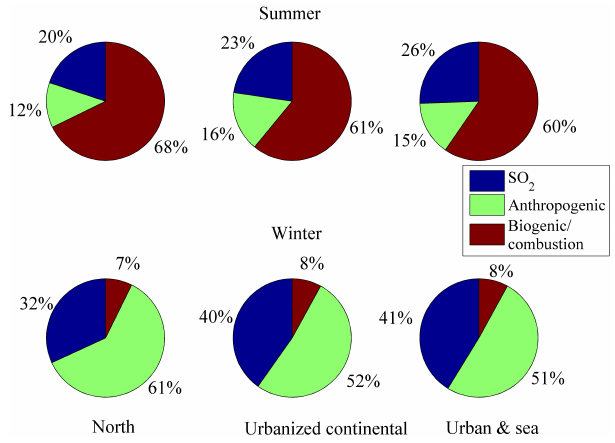
Figure 8. Pie charts of mean values of sources in each sector during summer (June–August) (topmost row) and during winter (December–February) (bottom row). The north sector includes data from direction 0–5 and 300–360 ◦ , urbanized continental from 5– 210 ◦ and urban and sea sector from 210–300 ◦